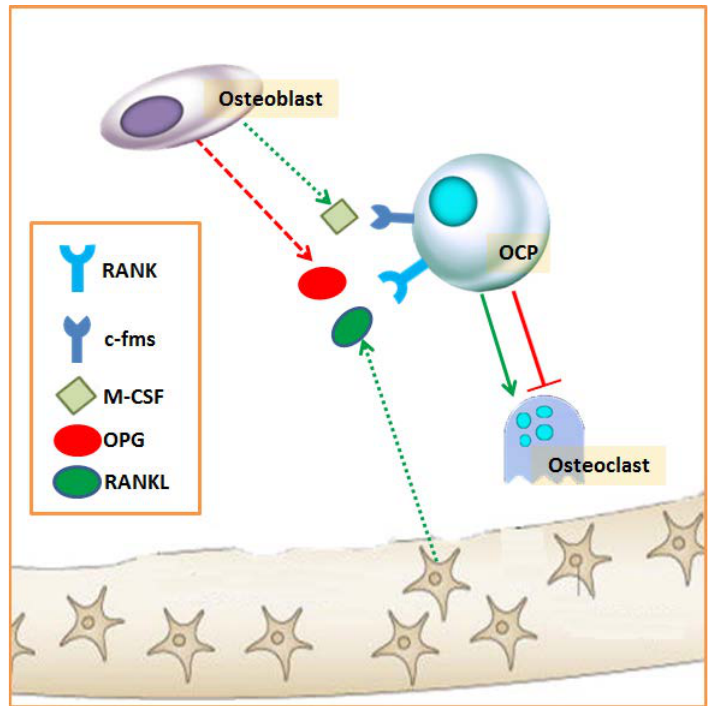
Figure 2. Activation phase of bone remodeling. c-fms: M-CSF receptor; M-CSF: macrophage colony-stimulating factors; OCP: osteoclast precursor; OPG: osteoprotegerin; RANKL: receptor activator of NF-kB ligand; RANK: RANKL